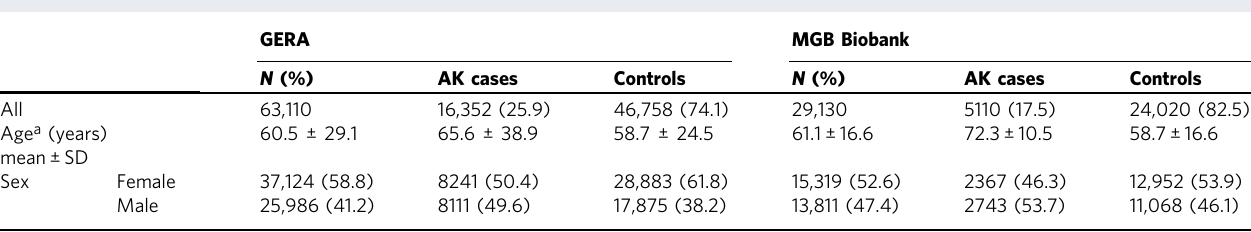
Table 1 Characteristics of GERA and MGB Biobank NHW subjects with AK (cases) and controls. GERA MGB